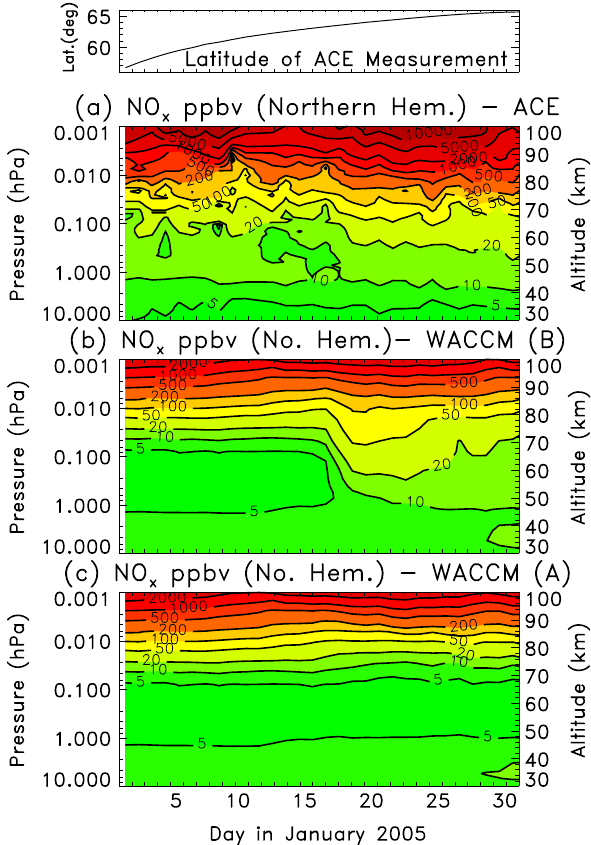
Fig. 12. Daily averaged NO x measurements (a) and predictions (b, c) for 1–31 January 2005 in the high latitude Northern Hemisphere (see Sect. 5.2.3). The ACE NO x measurements are given in (a) . The WACCM3 NO x predictions are from an average of the B re- alizations (b) and the A realizations (c) . The contour intervals for NO x are 1, 2, 5, 10, 20, 50, 100, 200, 500, 1000, 2000, 5000, and 10000ppbv. The latitudes of ACE measurements are given in the top